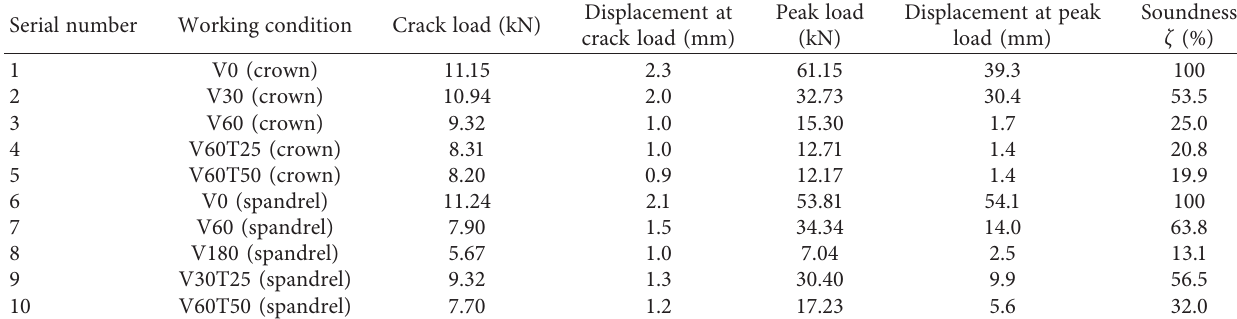
Table 3: Main experimental results of lining